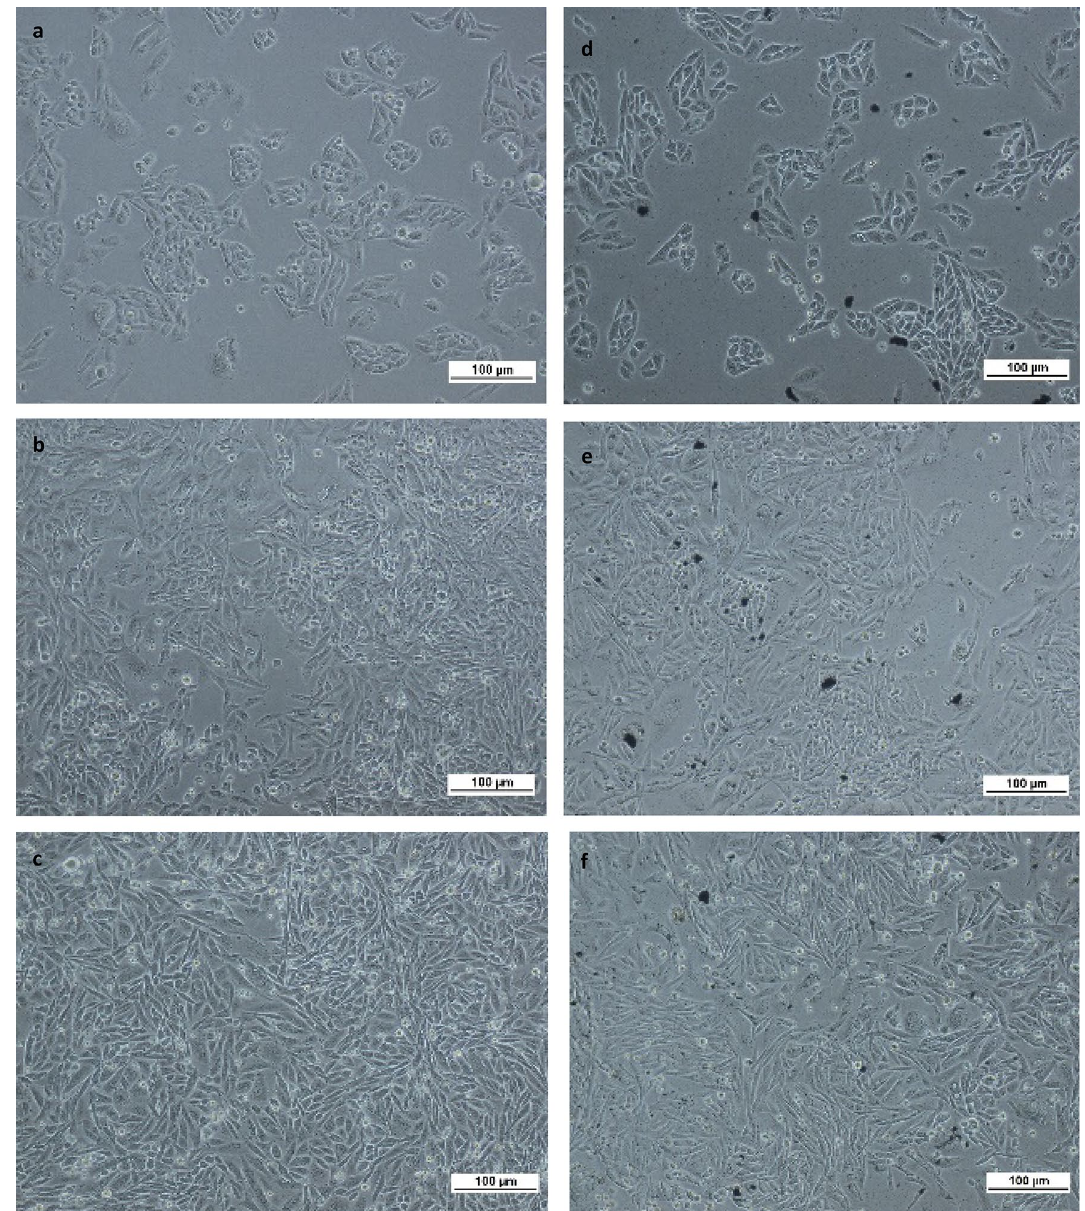
Figure 2. Microscopic characterization of non-GZ-treated MRC5 cells at ( a ) 24 h, ( b ) 48 h, ( c ) 72 h, and GZ-treated MRC5 cells at ( d ) 24 h, ( e ) 48 h, ( f ) 72 h. The presence of GZ nanocomposite did not present